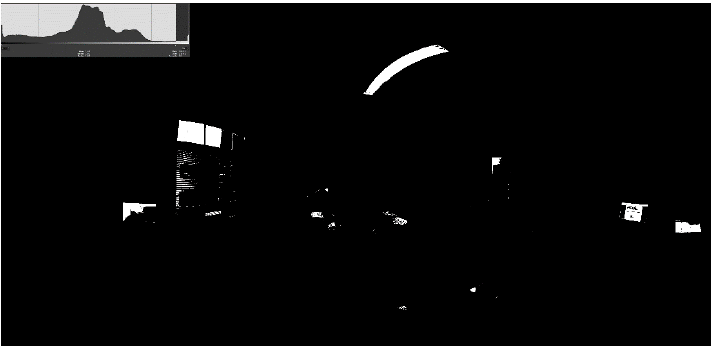
Figure 7. Ninety-three percent of the entire spectrum covers 98.9% of pixels.